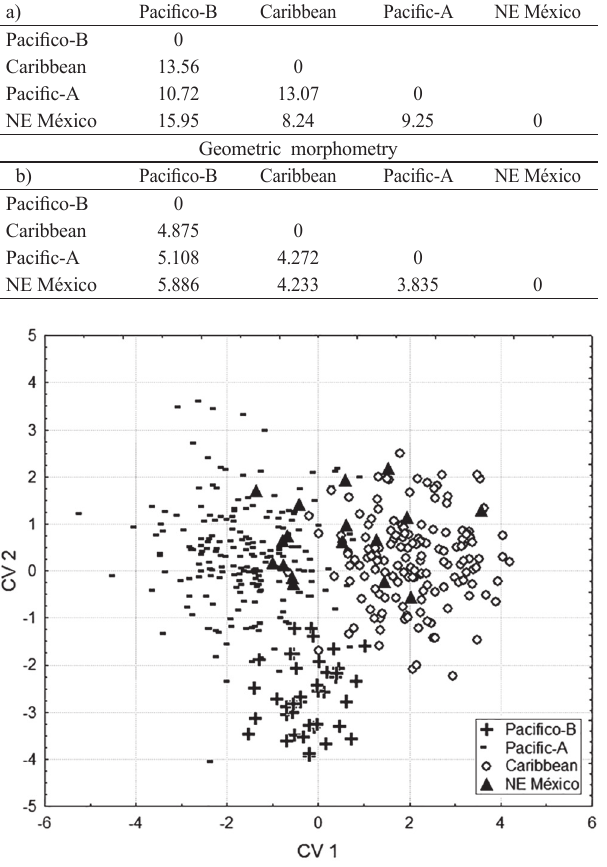
Fig. 3. Plot showing the classification of individuals Agonostomus monticola resulting from the discriminant function analysis using linear body measurements.